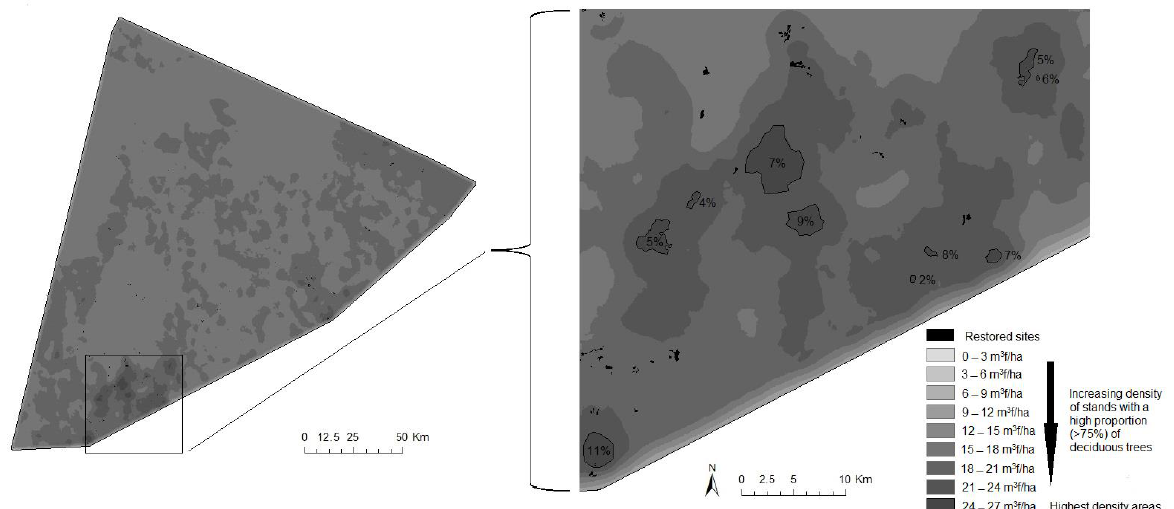
Figure 6. Density map showing (1) the areas with the highest density of stands with a high percentage of deciduous trees (>75%) and (2) locations of the restored sites for the entire study area and a portion of the study region with highest densities. The % values show the percentage of high-deciduous forest per 500 ha in that specific area.